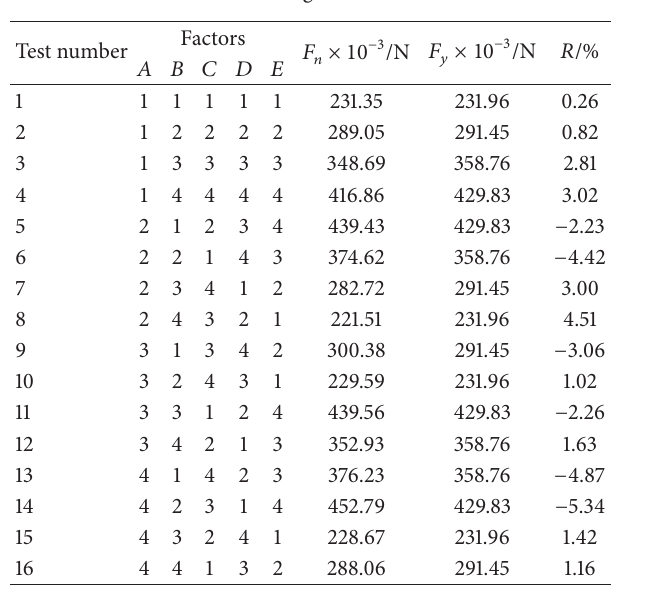
Table 2: Orthogonal test results.